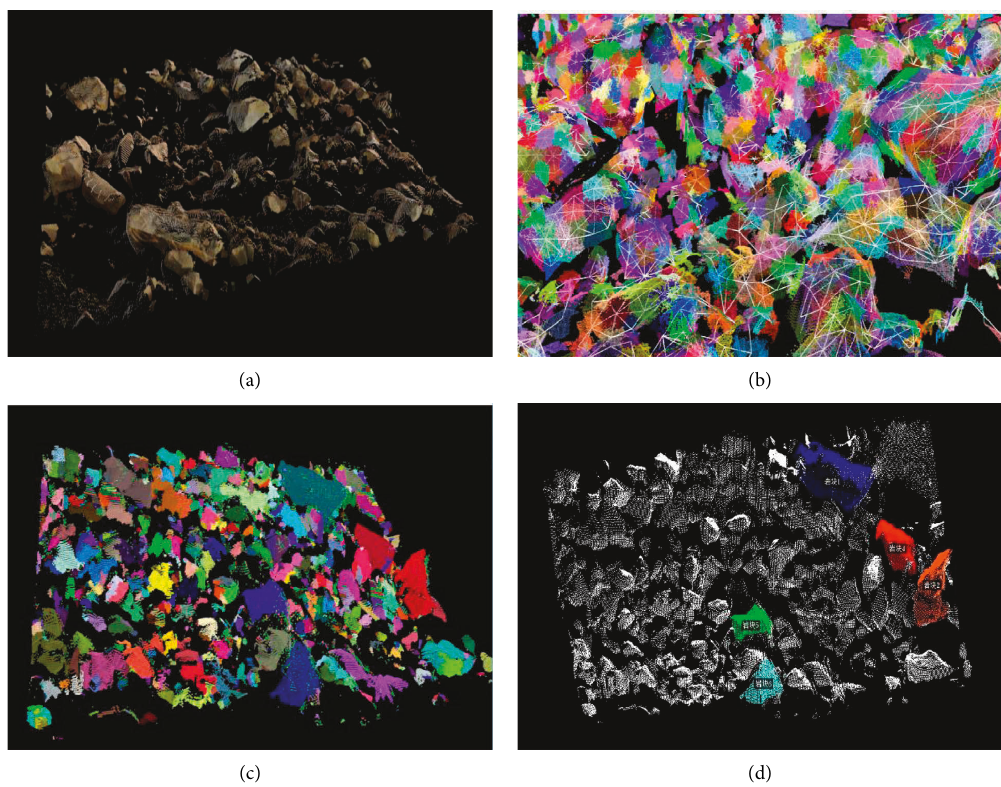
Figure 5: Fragmentation analysis based on the 3D laser scanning technique: (a) point cloud of blast muck pile; (b) supervoxel calculation; (c) block point cloud segmentation; (d) contour extraction for block point cloud.